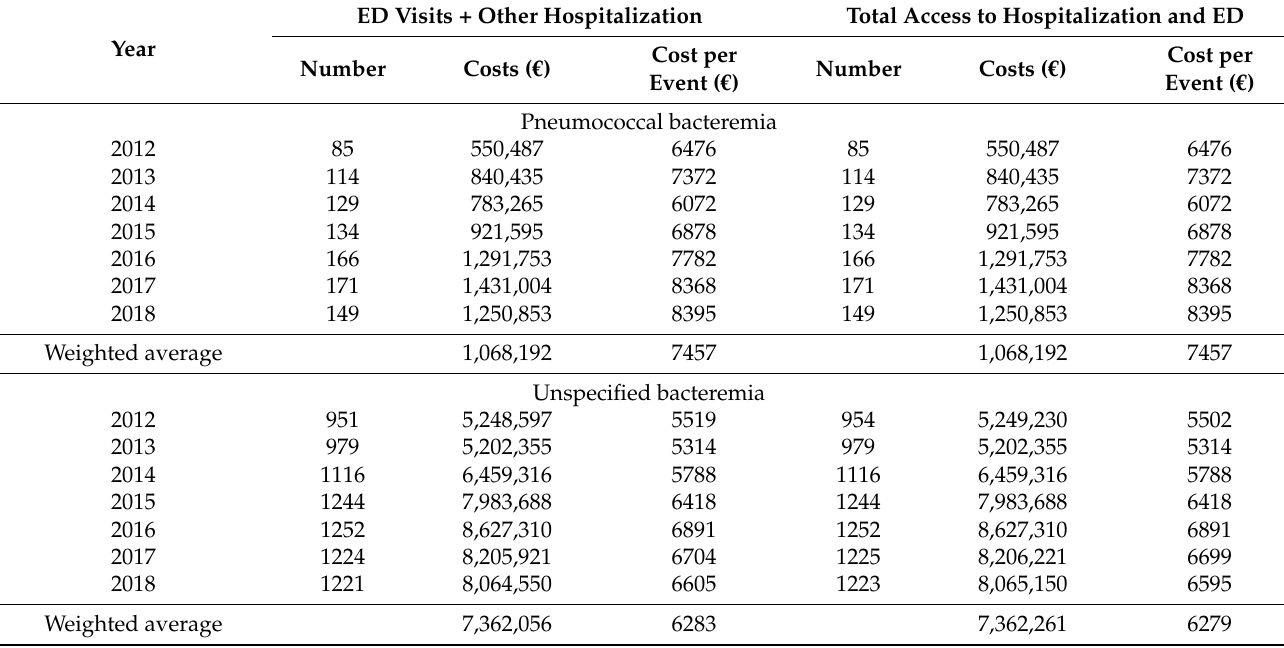
Table 5. Healthcare resource utilization and costs for bacteremia for individuals ≥ 15 years of age in the Liguria region 2012–2018.